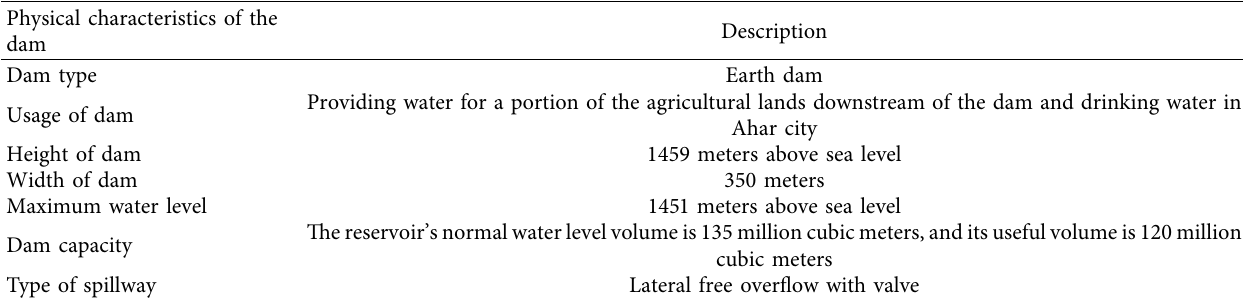
Figure 4: Different components of Sattarkhan Dam. Table 1: General physical characteristics of Sattarkhan Dam.